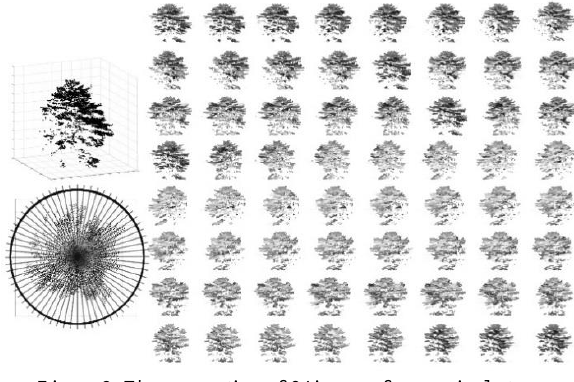
Figure 3. The generation of 64images from a single tree, example shows the results generated for